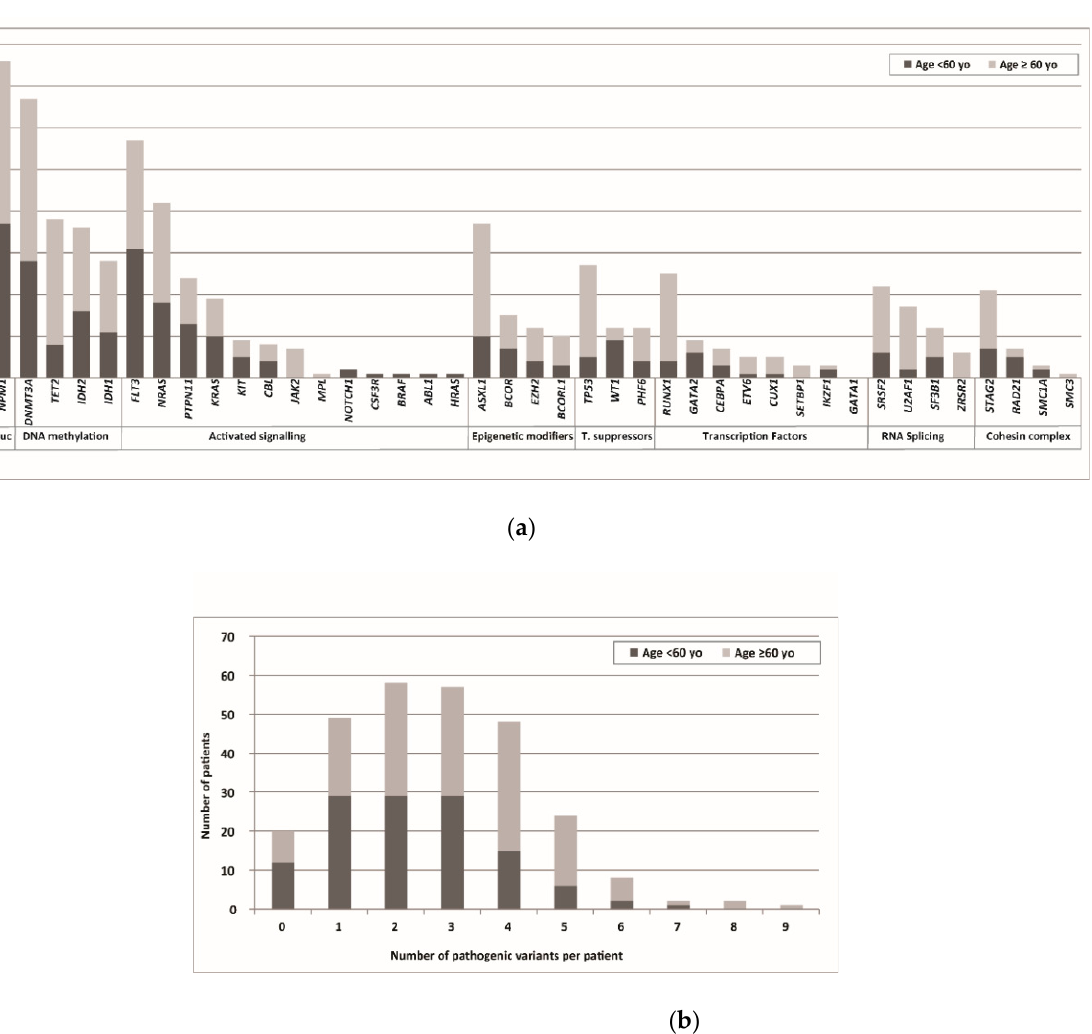
Figure 3. Mutational landscape according to age. ( a ) Mutated genes were grouped into functional categories as in Figure 2. Each bar represents patients harboring a mutation in the indicated gene according to age, in younger (<60 years) and elderly ( ≥ 60 years) patients. ( b ) Number of pathogenic variants identified per sample in younger (<60 years) and elderly ( ≥ 60 years) patients. Table 3. Frequency of selected gene mutations according to age.